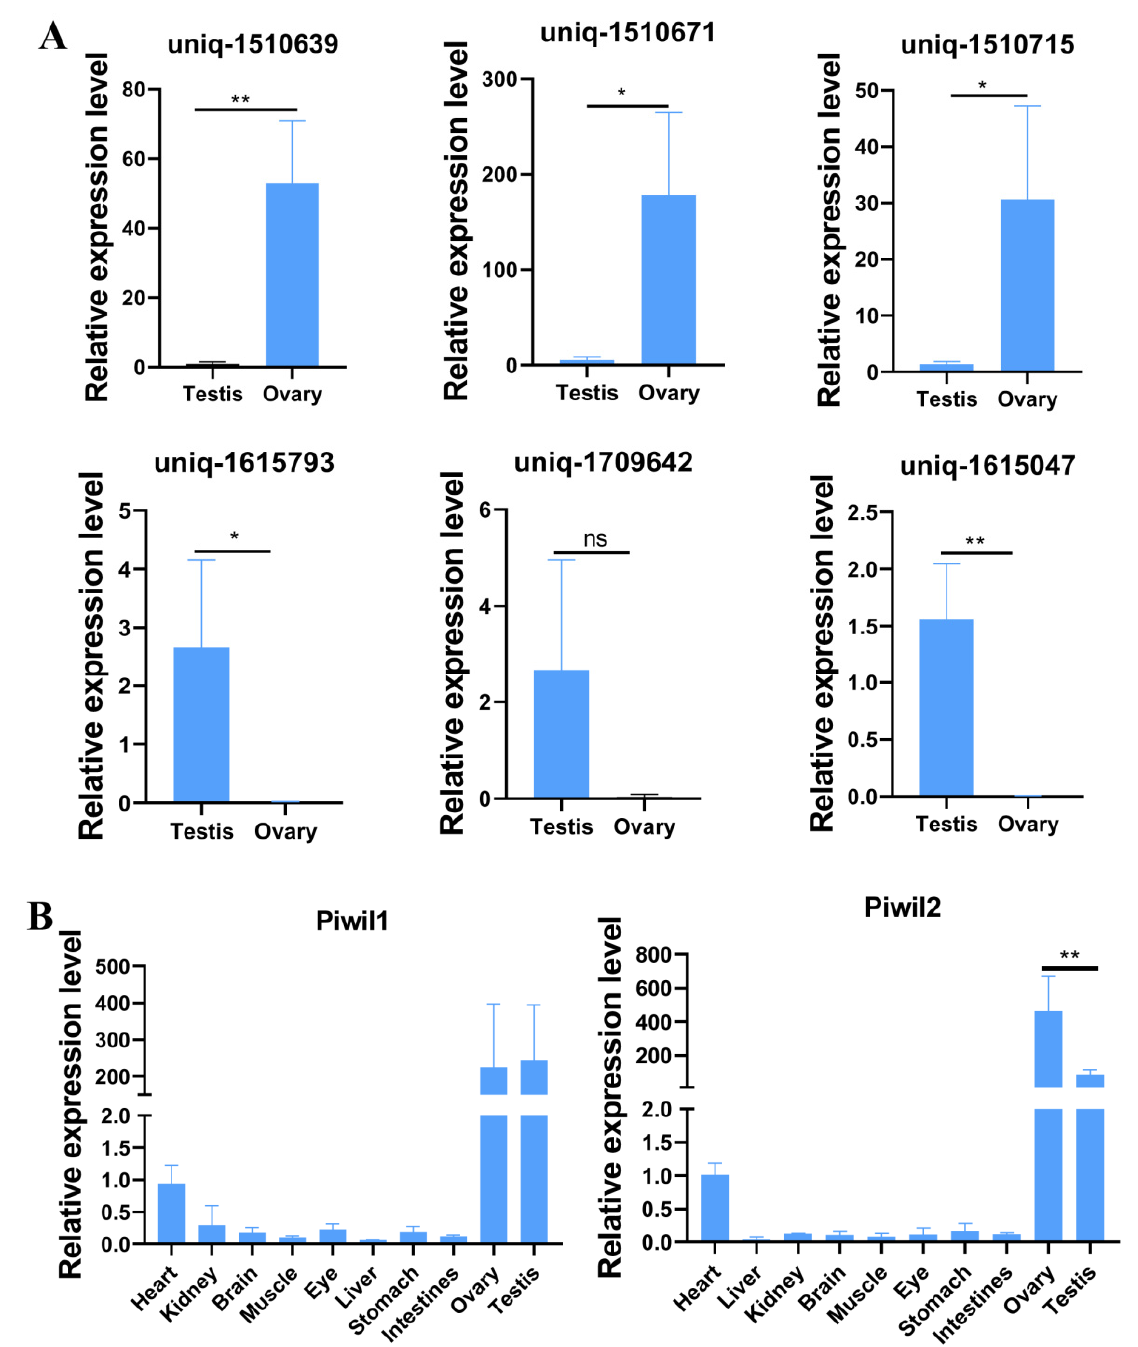
Figure 7. Validation of differentially expressed piRNAs. ( A ) Verification of six differentially expressed piRNAs by real-time PCR. N = 3, t-test. * p < 0.05, ** p < 0.01. ( B ) Expression of piwil1 and piwil2 detected by real-time PCR. N = 3. One-way ANOVA, ** p < 0.01 comparison between testes and ovaries, and p < 0.01 compared with testes and ovaries.